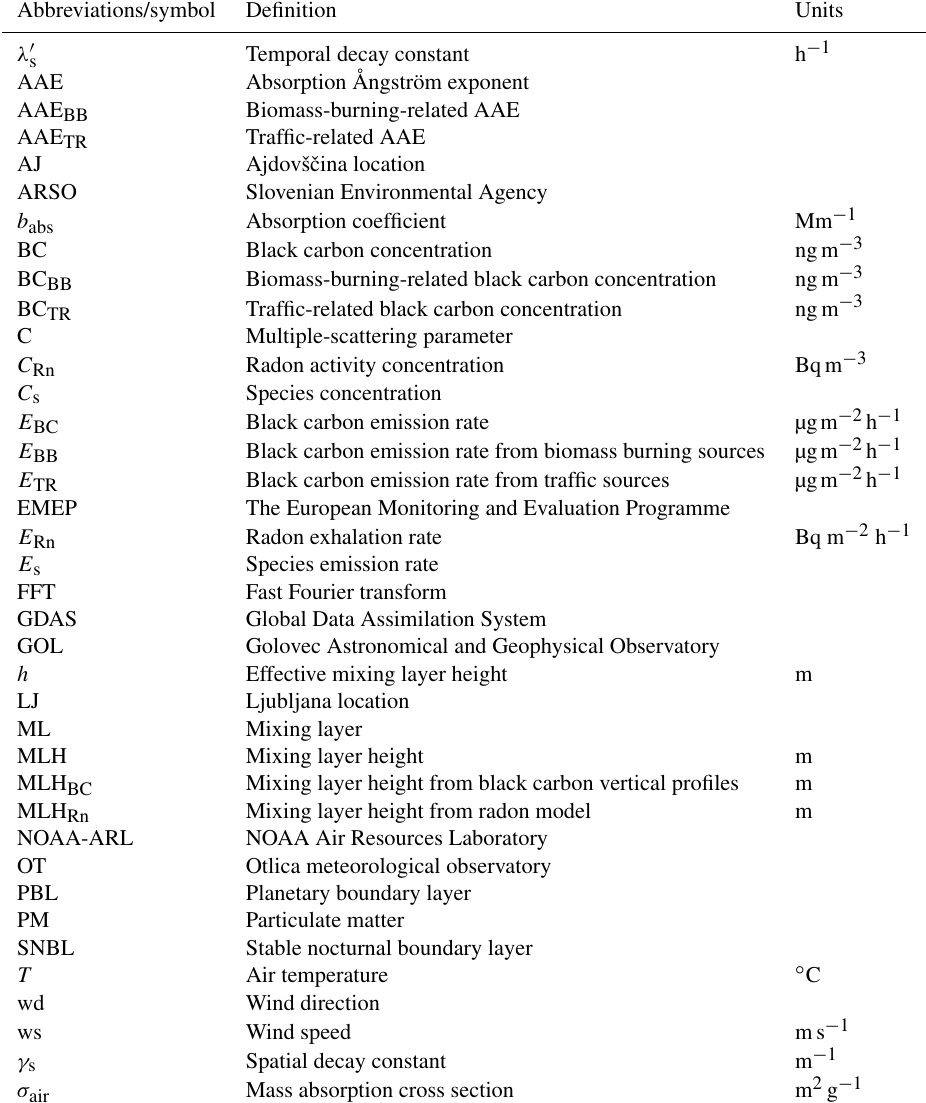
Table 1. List of symbols and